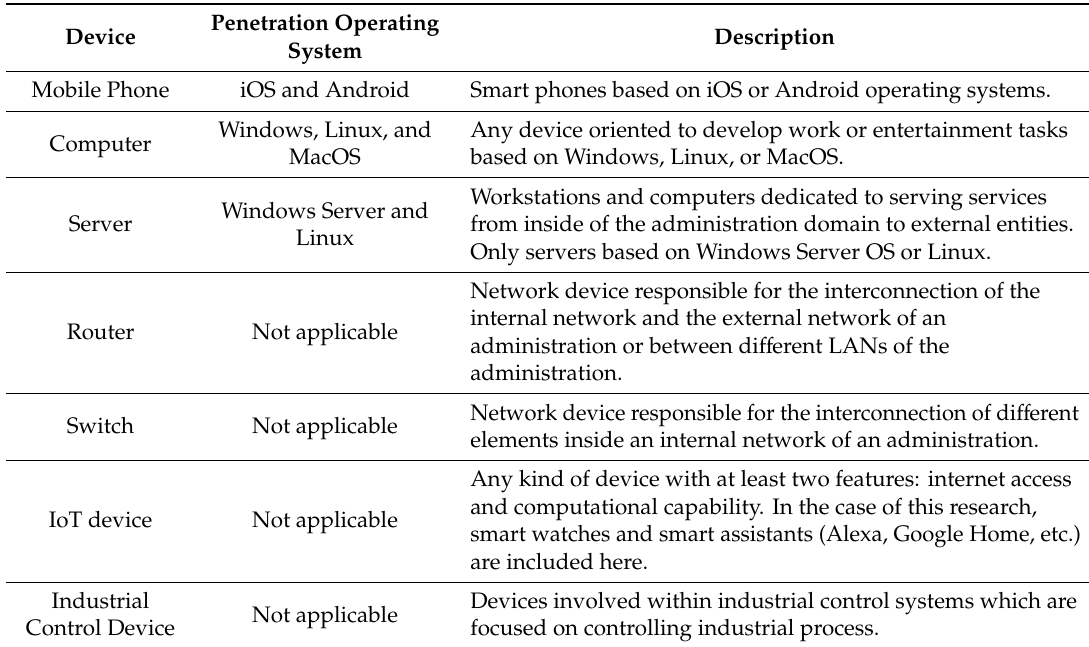
Table 2. Classification of the di ff erent devices related to each actor within the administrative